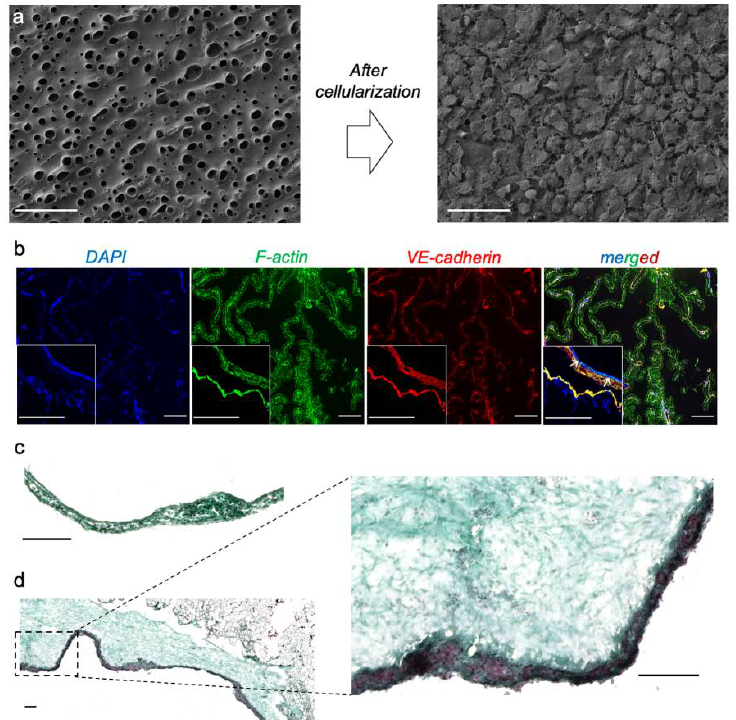
Figure 2. The biocompatibility of the BETA scaffold. ( a ) Scanning electron microscopy (SEM) of the BETA scaffold, which has already been introduced by us elsewhere [21]. The cells were populated onto and into the porous BETA scaffold with alveolar epithelial type II-like A549 cells within 5 days. The scale bars of the SEM images are 50 µm. ( b ) The chick chorioallantoic membrane (CAM) assay was used to evaluate the biocompatibility of the BETA scaffold. The immunofluorescence (IF) analysis showed the formation of blood vessels on the BETA scaffold characterized by VE-cadherin (red). Cell nuclei are shown in blue (DAPI) and F-actin cytoskeleton in green. ( c , d ) The CAM-deposited